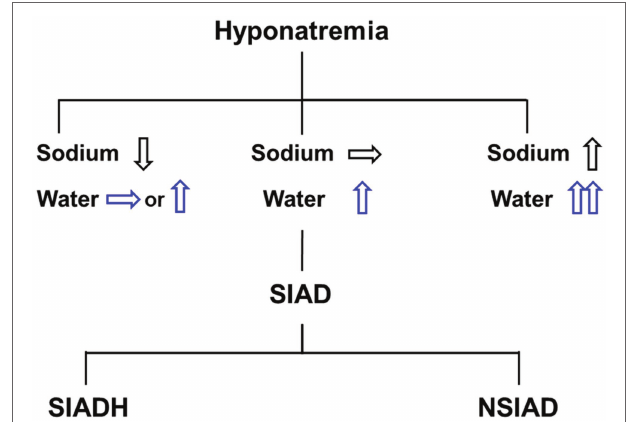
FIGURE 1 | Differential diagnosis of hyponatremia. Hyponatremia may include water and sodium balance disorder, and pure water excess presents clinically with euvolemic hyponatremia. The syndrome of inappropriate antidiuresis (SIAD) is the most common cause of euvolemic hyponatremia and can be classified into the syndrome of inappropriate antidiuretic hormone secretion (SIADH) and the nephrogenic syndrome of inappropriate antidiuresis